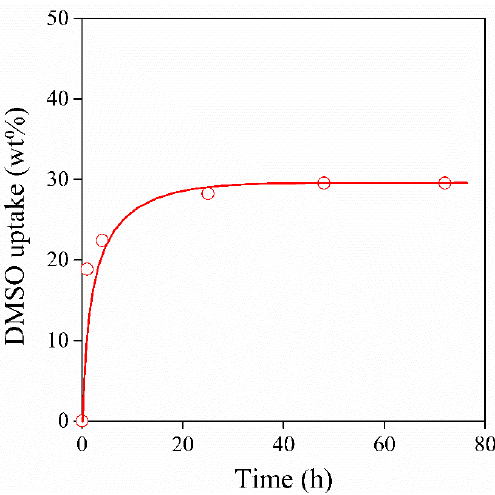
Figure 4. DMSO uptake of a PLA plate plotted as a function of time.